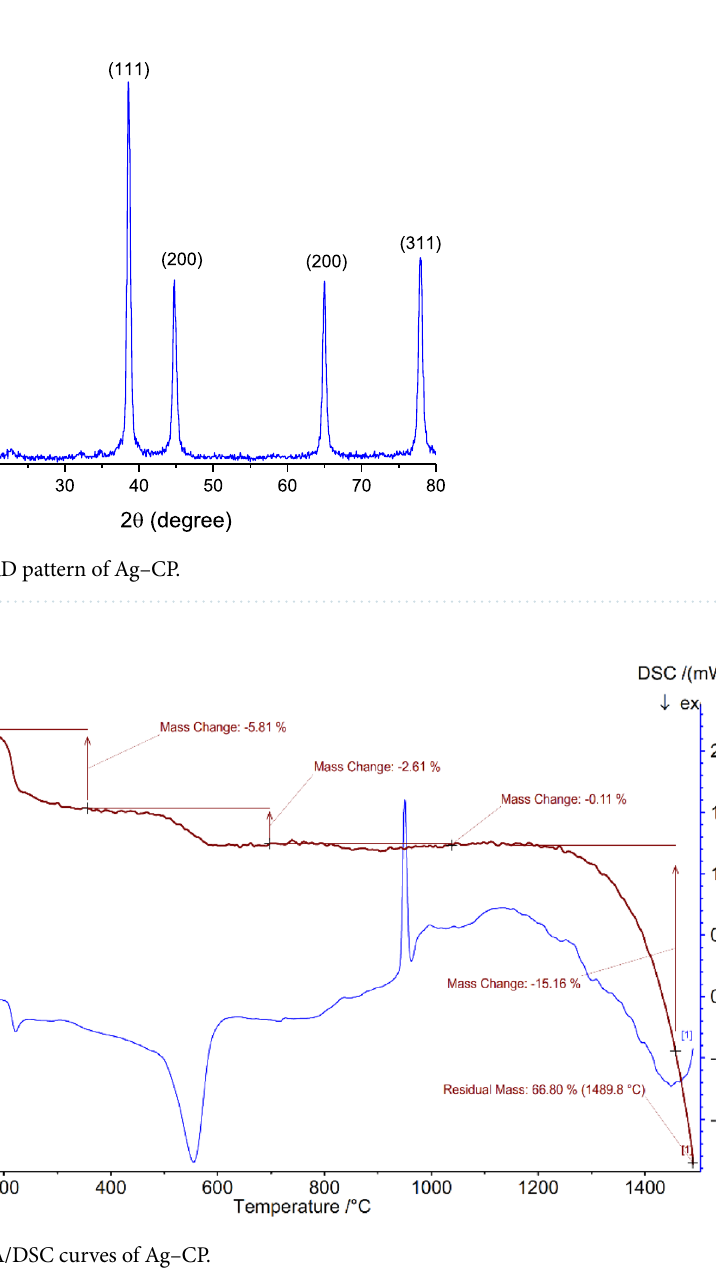
Figure 3. TGA/DSC curves of